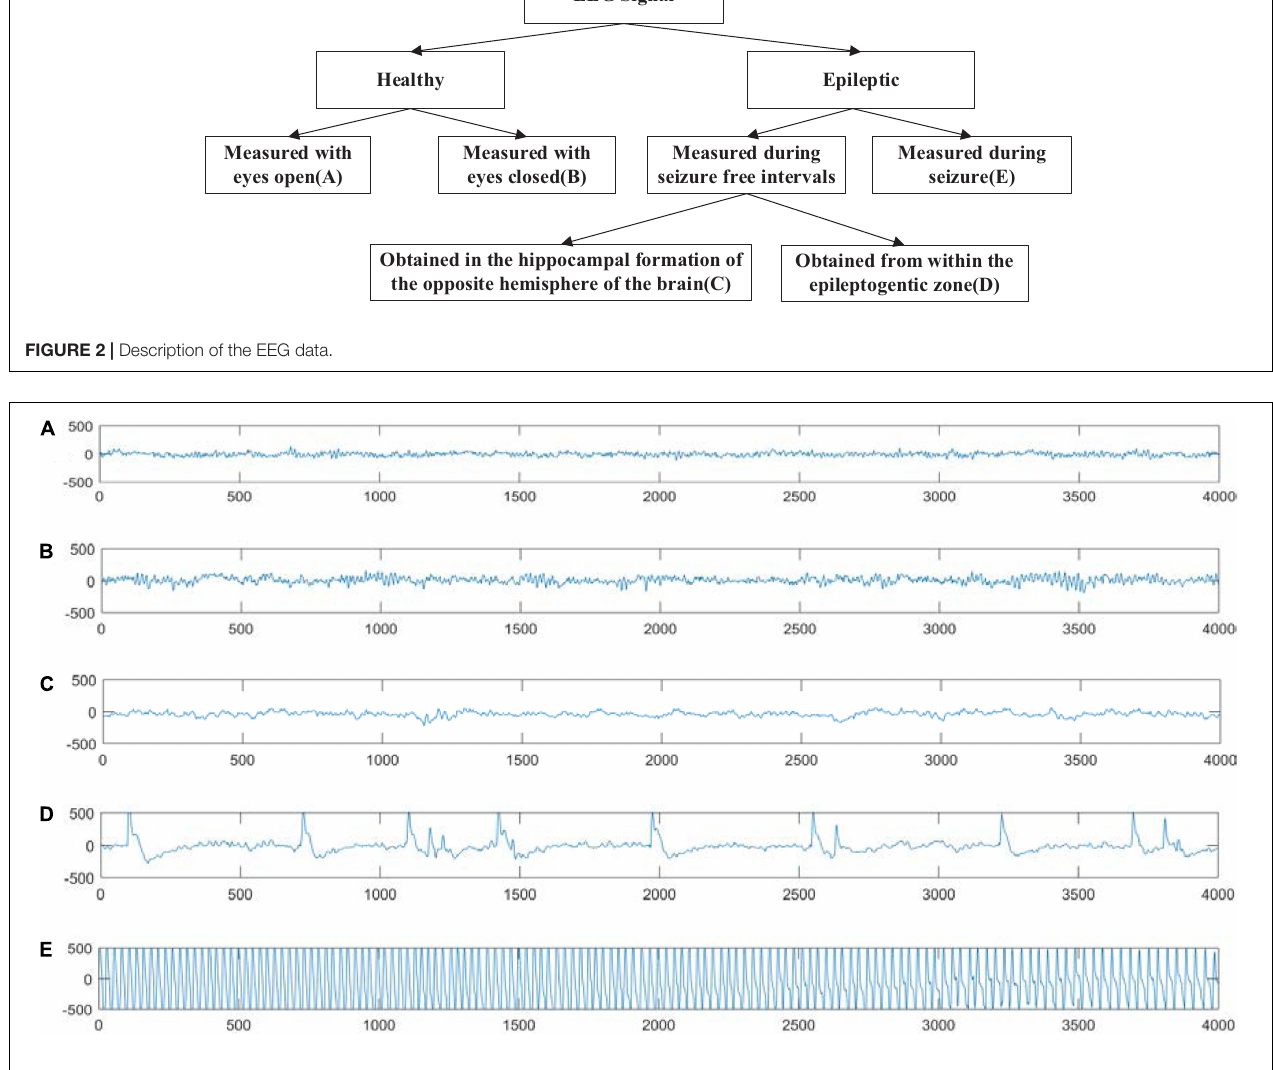
FIGURE 3 | Typical EEG signals in groups (A–E)